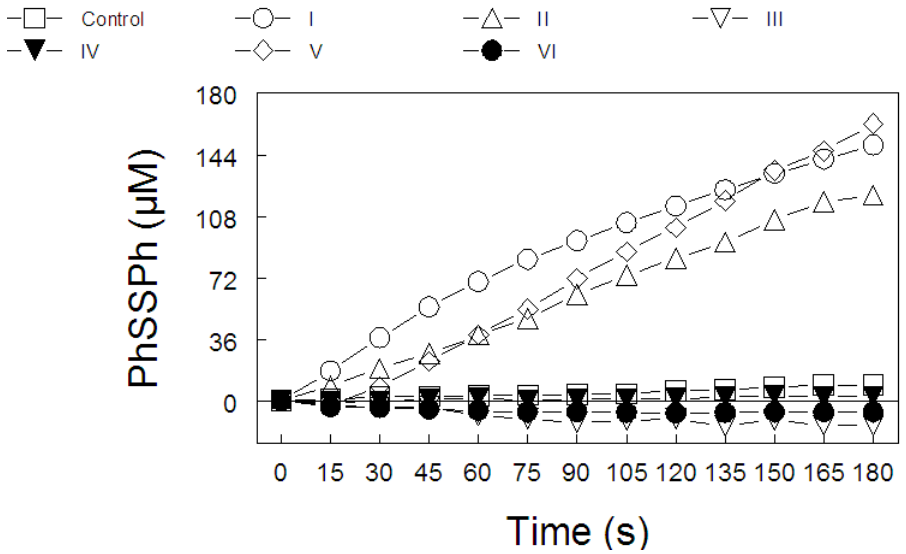
Figure 4. GPx like behavior of diselenide compounds: ( I ) diphenyl diselenide, ( II ) bistrifluoromethyldiphenyl diselenide, ( III ) bismethoxydiphenyl diselenide, ( IV ) biscarboxydiphenyl diselenide, ( V ) bischlorodiphenyl diselenide and ( VI )